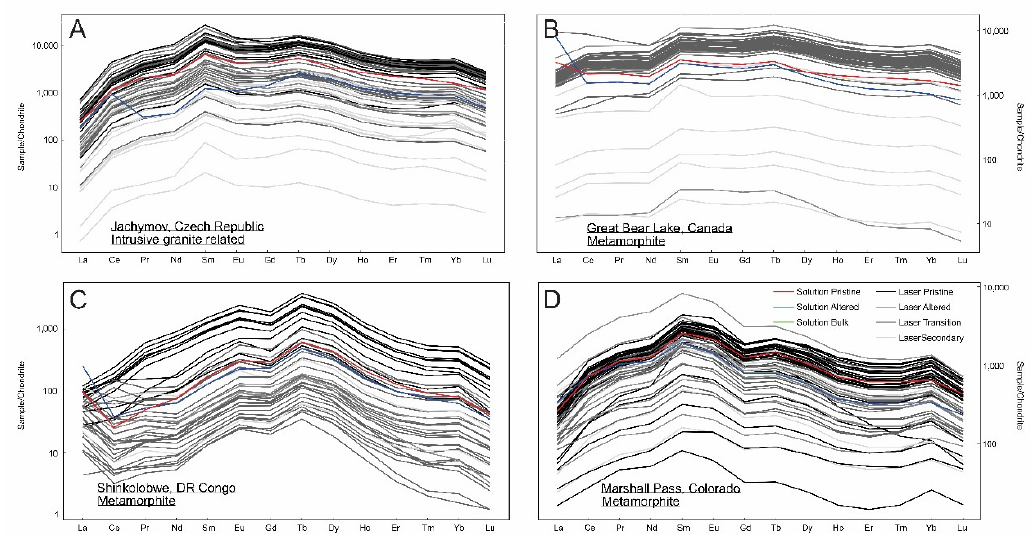
Figure 3. Chondrite normalized REE patterns for the ( A ) Jachymov, ( B ) Great Bear Lake, ( C ) Shinkolobwe, and ( D ) Marshall Pass uraninite samples. The gray and black indicate UO 2 wt% abundance; black ≥ 80 wt%, gray 80 = altered (UO 2 70–80 wt%), gray 60 = transition (UO 2 50–70 wt%), and gray 40 = secondary (UO 2 < 50 wt%). The colored line (red = pristine, blue = altered, and green = bulk) indicate abundances determined by solution-ICP-MS.